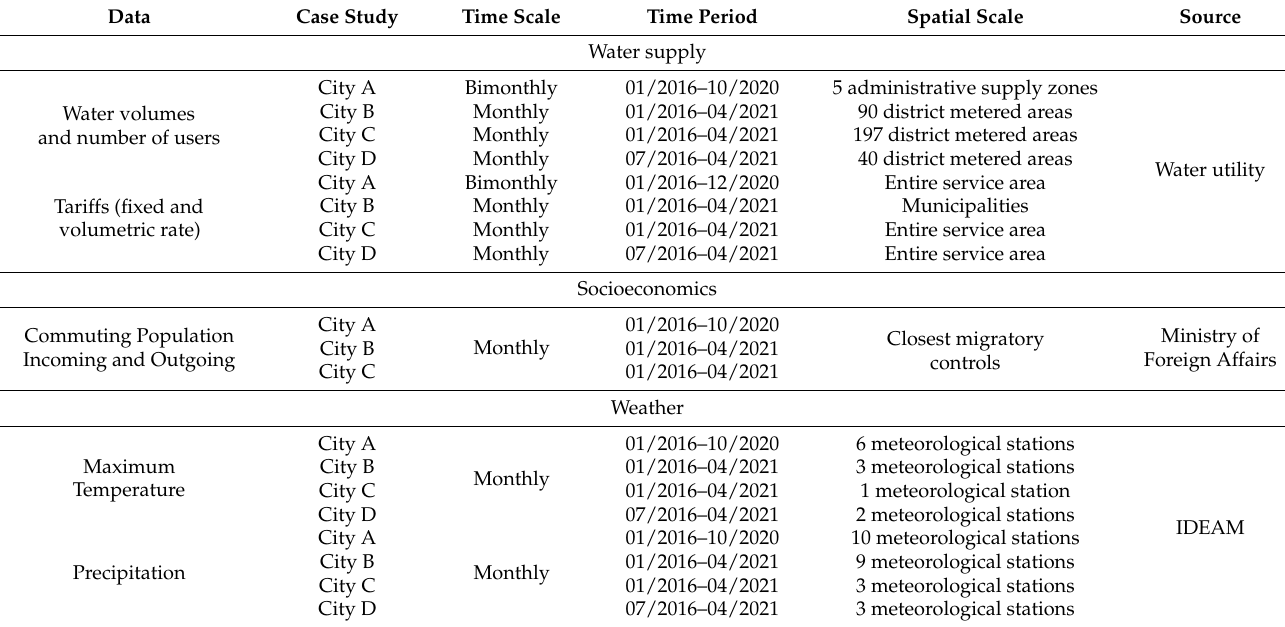
Table 2. Summary of the data used for the